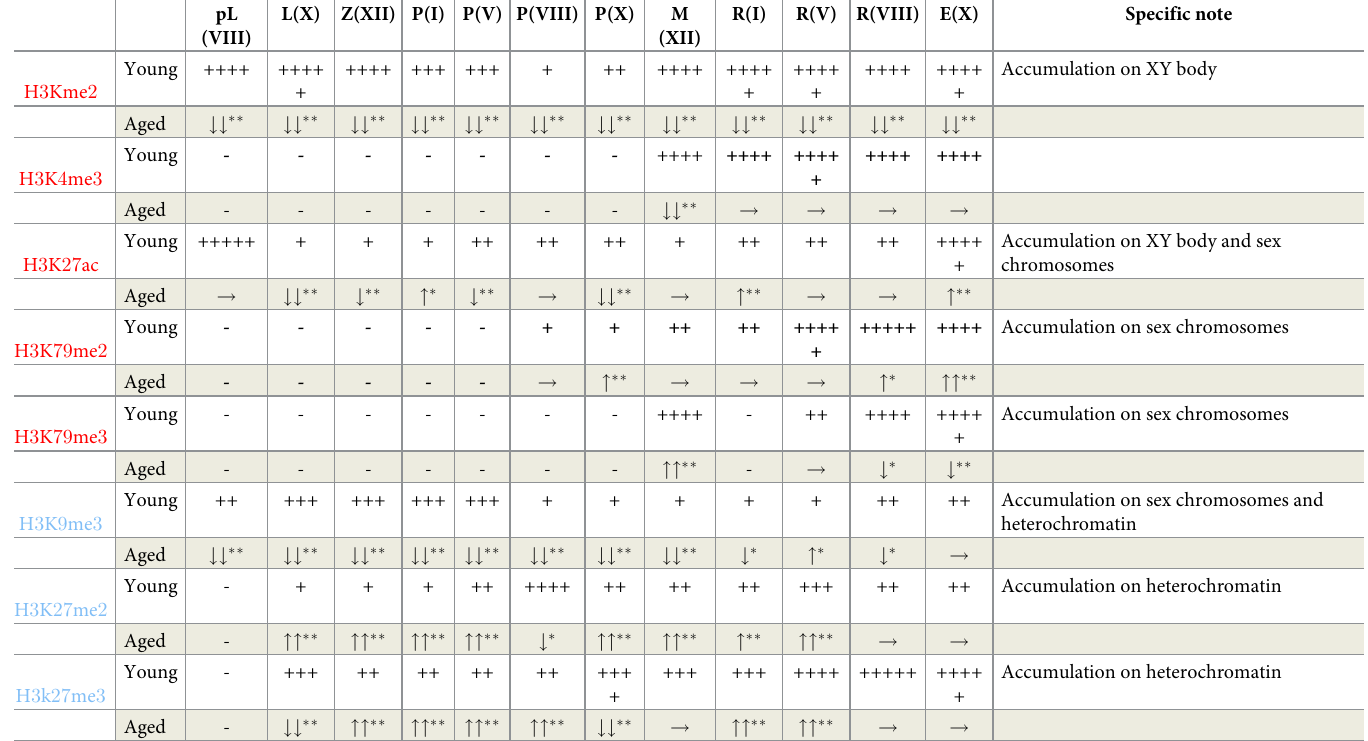
## �� ! "" �� "" �� ! ! Accumulation levels of histone modifications that activate (red) and inhibit (blue) gene expression are shown. Each histone modification level in male germline cells derived from young mice is indicated as–(not detected), + (normalized intensity < 0.4), ++ (0.4–0.6), +++ (0.6–0.8), ++++ (0.8–1.0), and +++++ (1.0 < ) (Actual values for intensity young male germline cells are shown in S1 Table). Arrows show histone modification levels of male germline cells derived from aged mice compared to that of young mice. Single up/down arrows indicate that a signal was increased/decreased by less than 20% of the mean intensity compared to the signal from young animals. Double up/down arrows indicate that the signal was increased/decreased by more than 20% compared to the signal from young animals. Right arrows indicate that there were no significant differences between young and aged animals ( � p < 0.05, �� p < 0.01). Specific localization or accumulation is described in the specific notes